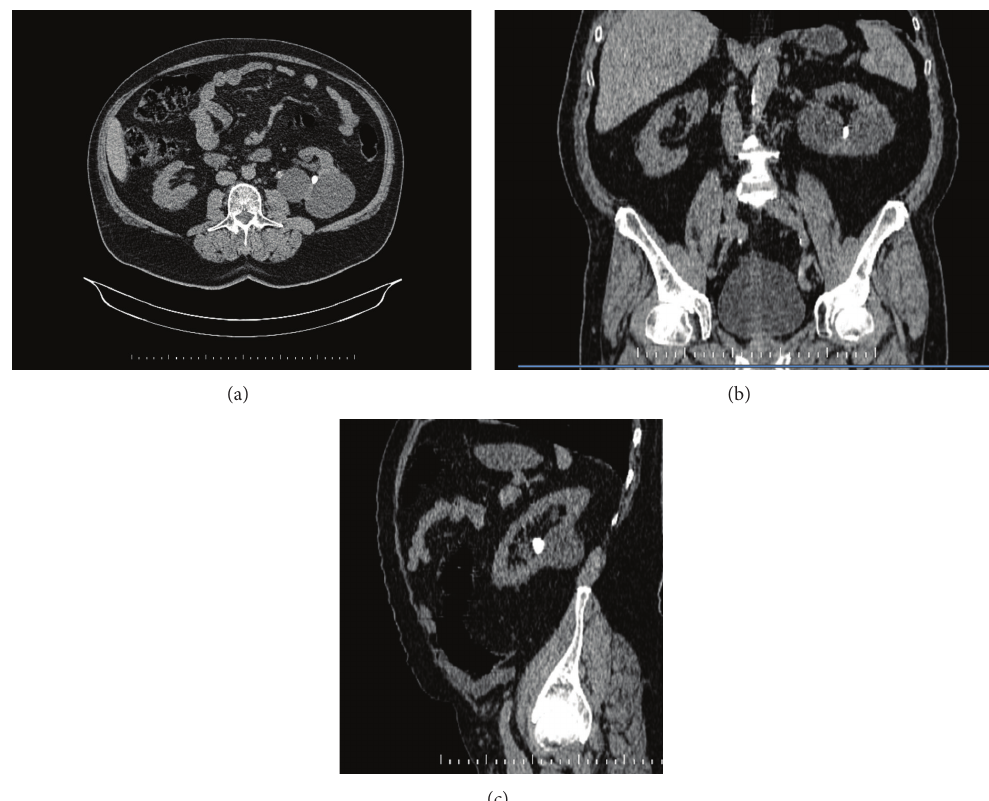
Figure 1: CT images of a patient with cysts and stone ((a) transvers, (b) coronal, and (c)